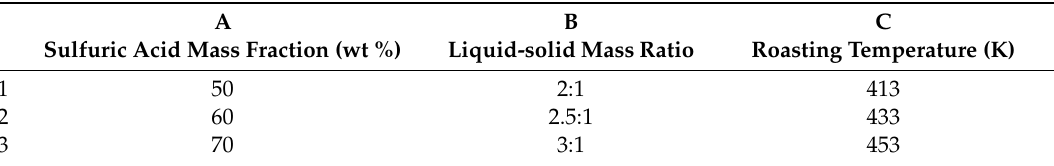
Table 4. The design of orthogonal experiment.